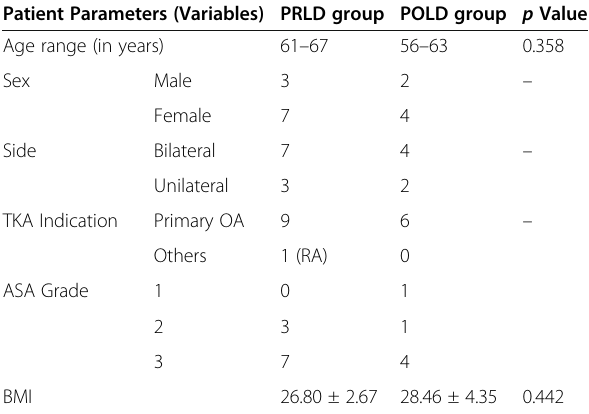
Table 1 Demographic data and patient distribution of the two